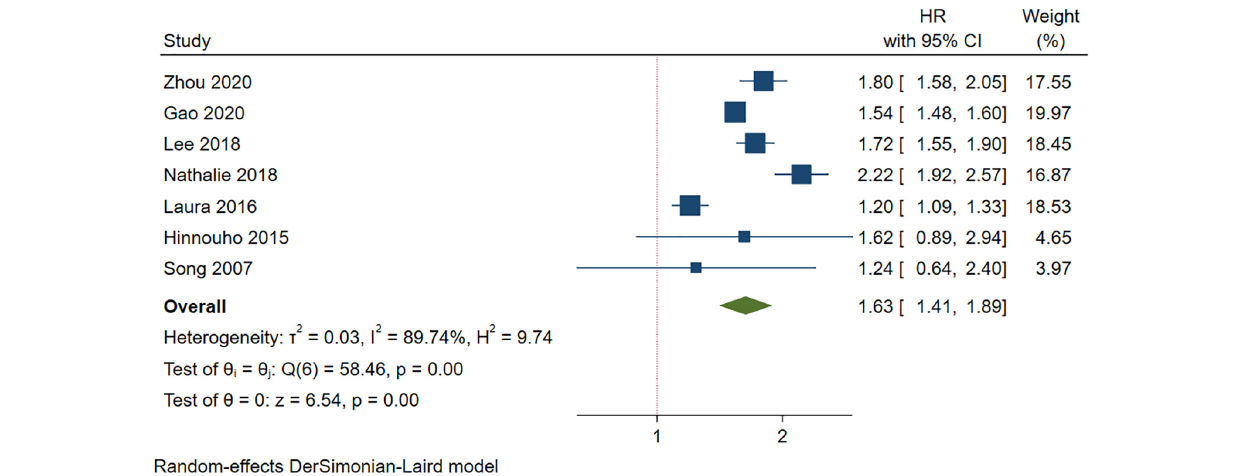
WHO defined obesity as a BMI of > 30 kg/m 2 (30), which was higher than any other criteria, such as the IOTF and the WGOC